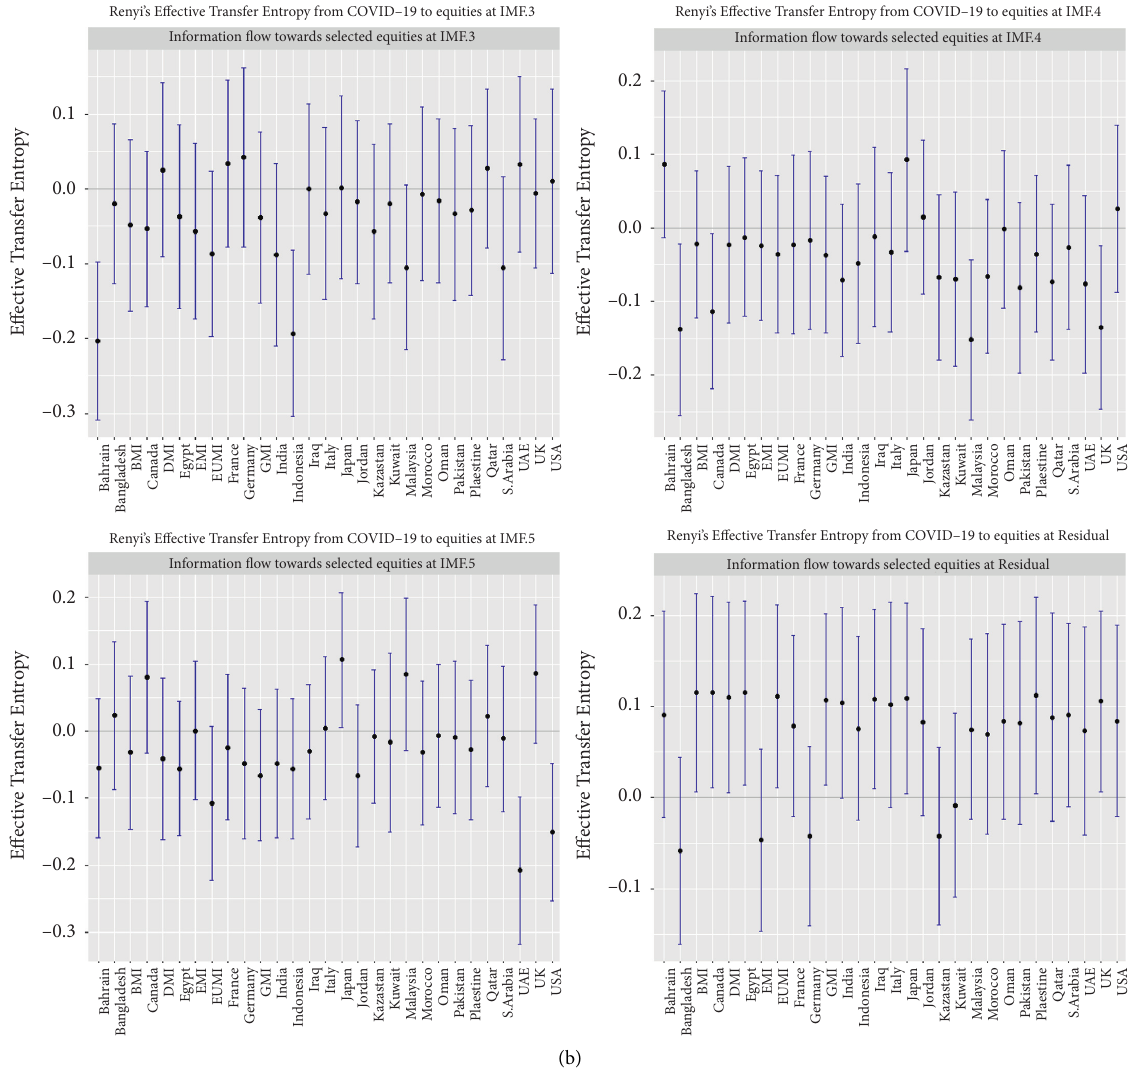
Figure 3: Composite and frequency-domain R´enyi ETEs from